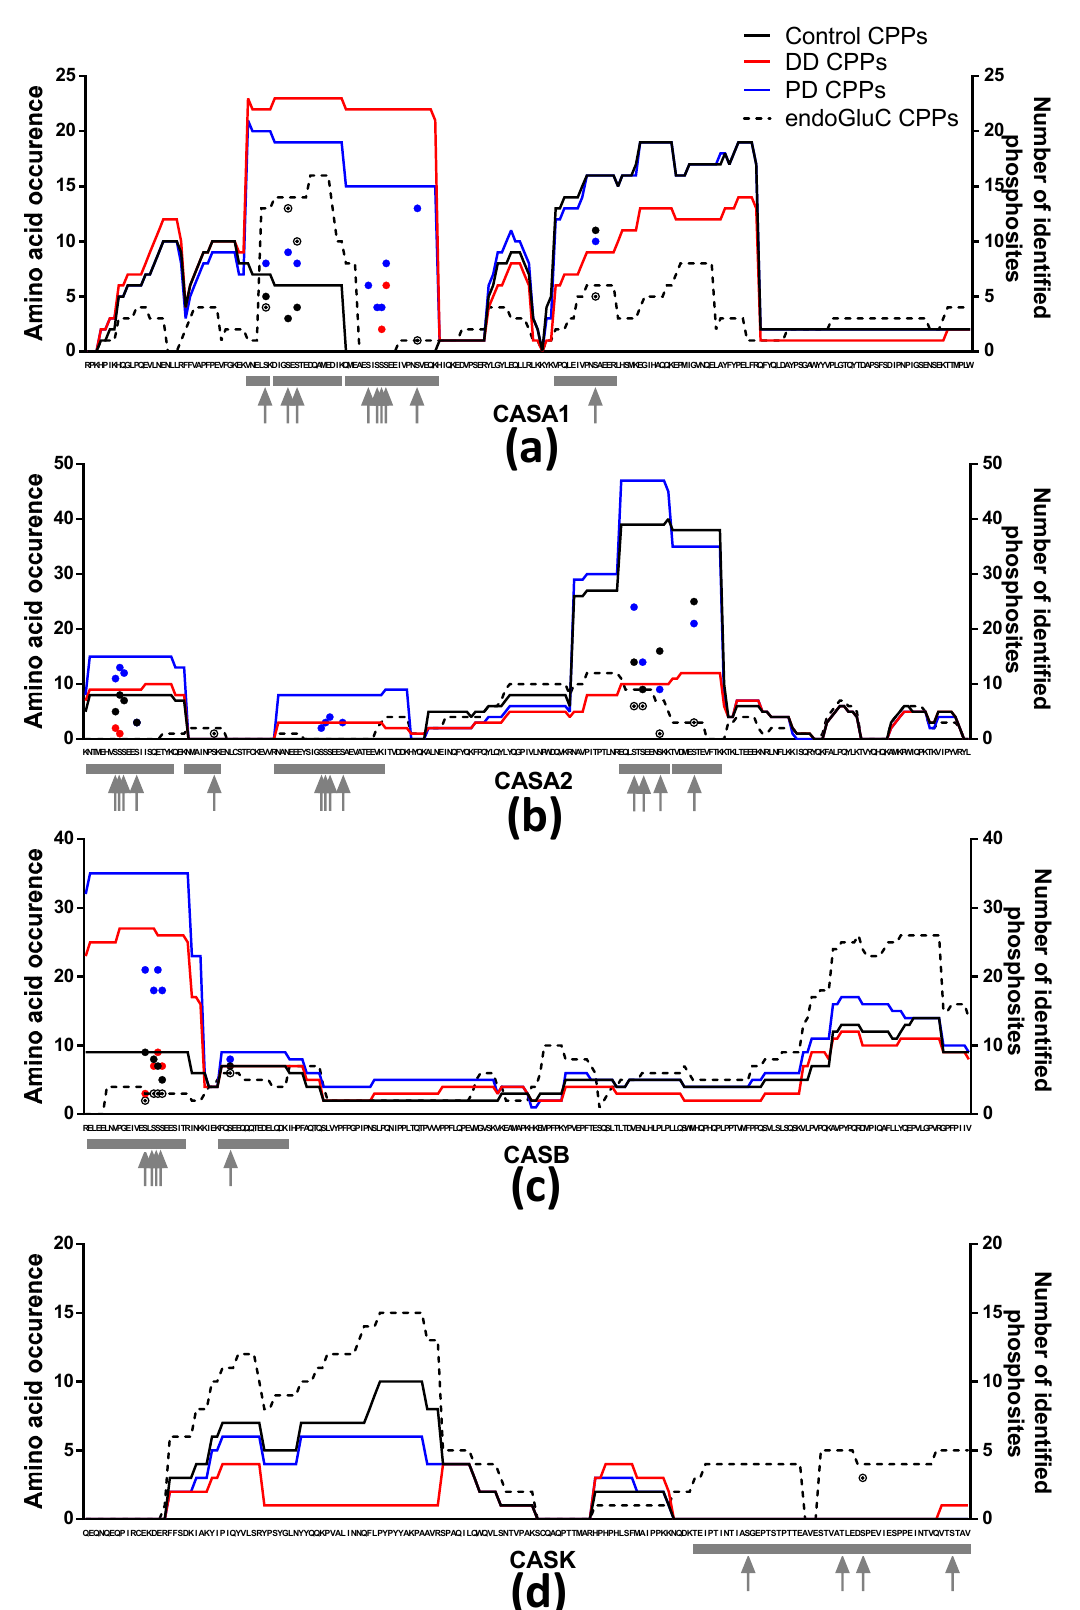
Figure 3. Peptide patterns of the control- (black lines and black dots), DD- (red lines and red dots), PD- (blue lines and blue dots) and endoGluC- (black dashed lines and black dashed dots) CPP hydrolysates for ( a ) alpha-S1 casein (CASA1), ( b ) alpha-S2 casein (CASA2), ( c ) beta-casein (CASB) and ( d ) kappa-casein (CASK). The X -axis represents the amino acid